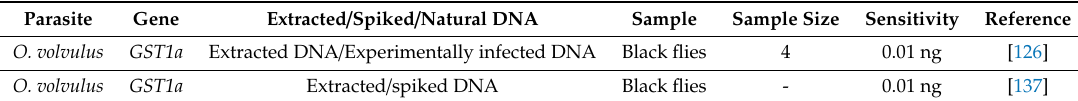
Table 13. Publications found in the US National Library of Medicine National Institutes of Health (NCBI-PubMed) reporting the standardisation of the LAMP technique as a useful tool for diagnosing onchocerciasis (river blindness) in the